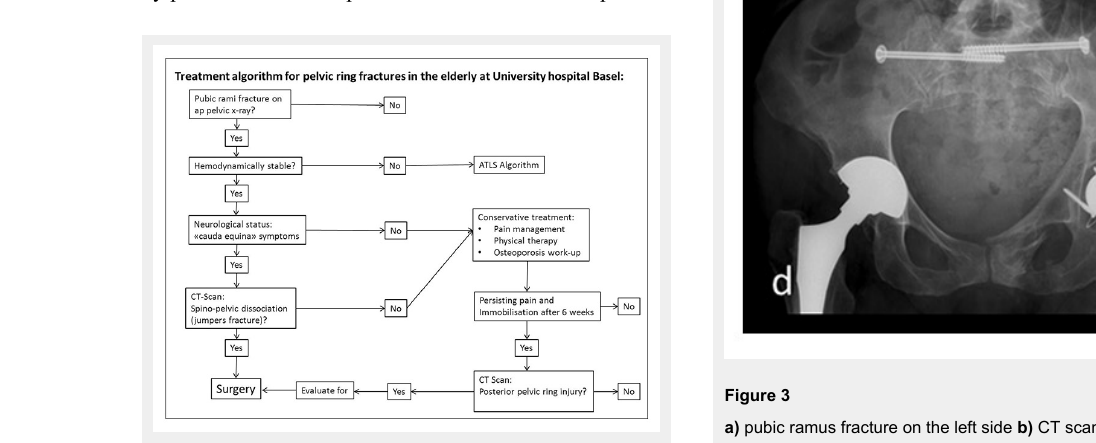
Table 2: Residential status and mortality.